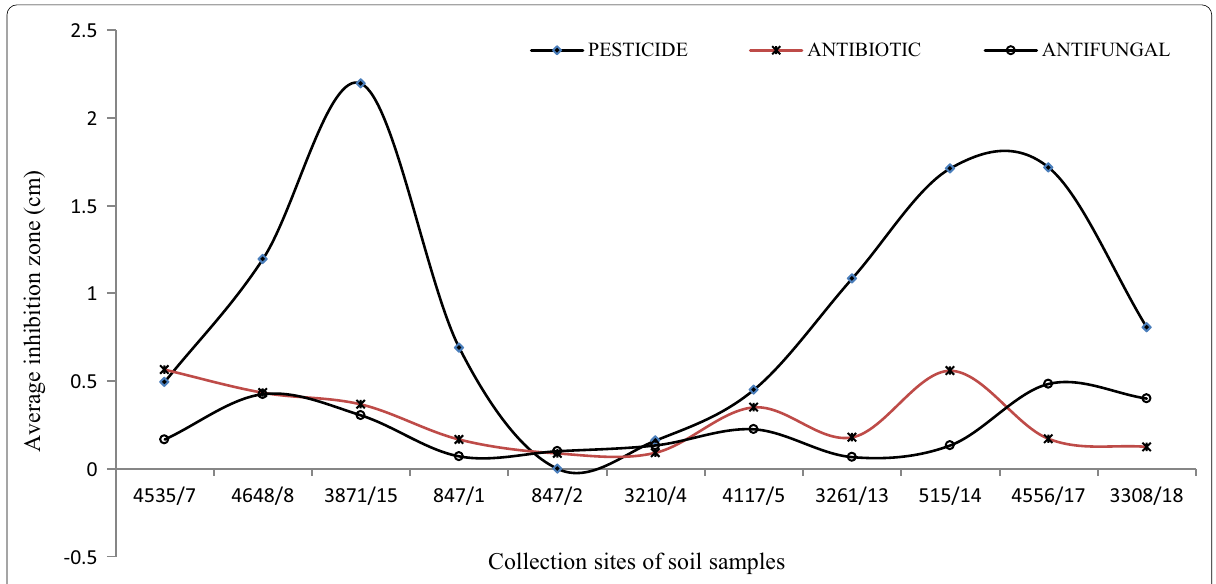
Fig. 7 Comparative illustration of pesticide, heavy metal salt, antibiotic and antifungal tolerance of PSMs isolated from organic practising (OP) and inorganic practising (INP) tea